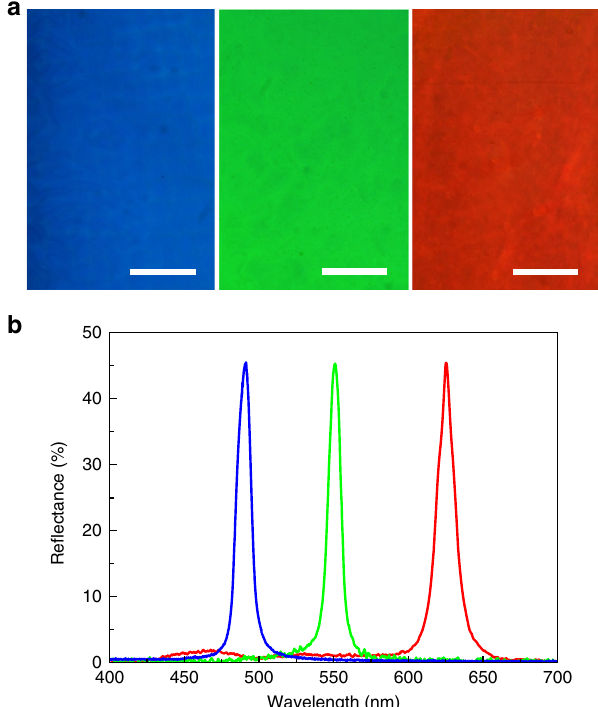
Fig. 5 Blue, green, and red re fl ections from large BP single crystals. a Microscope images of three different BPI single crystals ( scale bars , 200 μ m) and b respective re fl ection spectra for linearly polarized probe light. See “ Methods ” for fabrication details